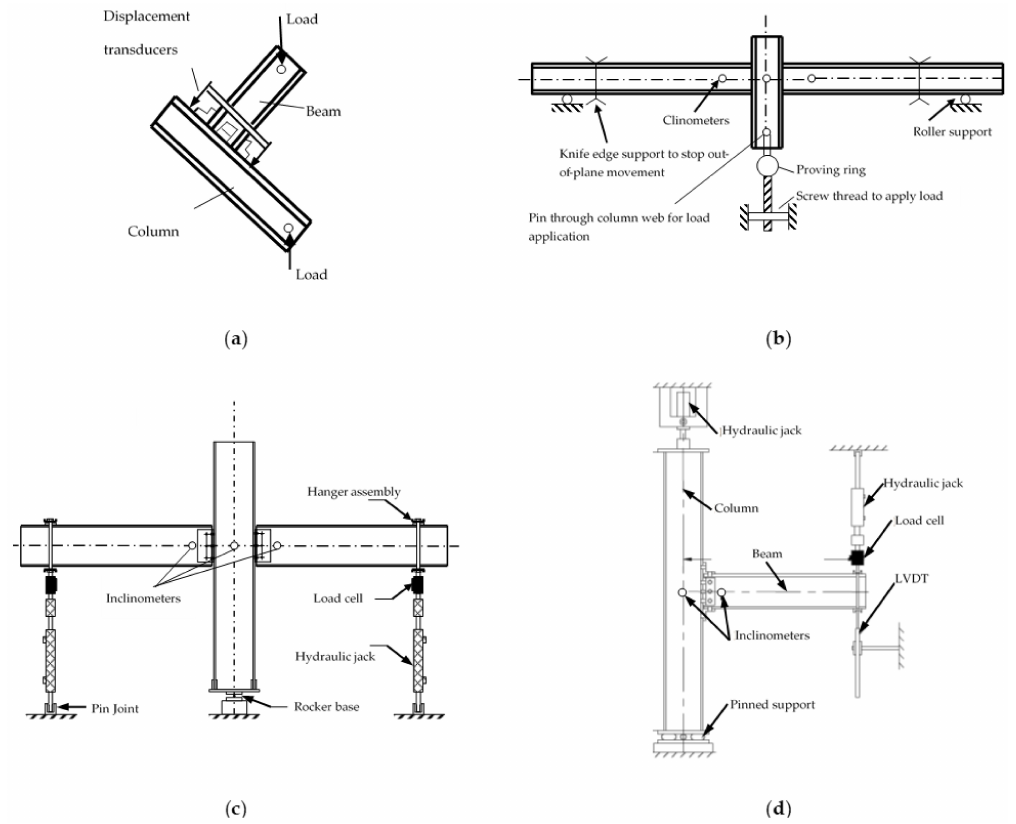
Figure 9. Test arrangement for beam-to-column joints; ( a ) Direct Compression [25]; ( b ) Simply supported beam [25]; ( c ) Double cantilever beam [27]; ( d ) Single cantilever beam